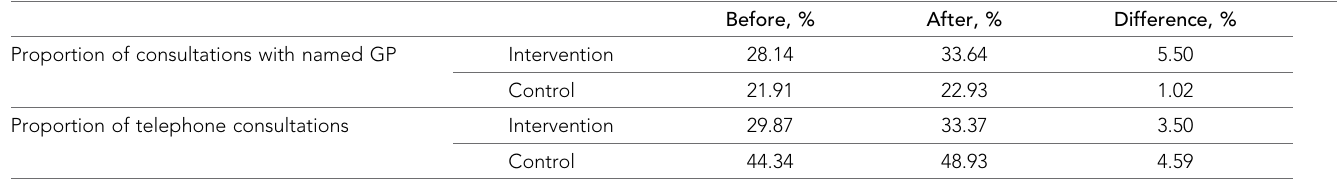
Before, % After, % Difference, %